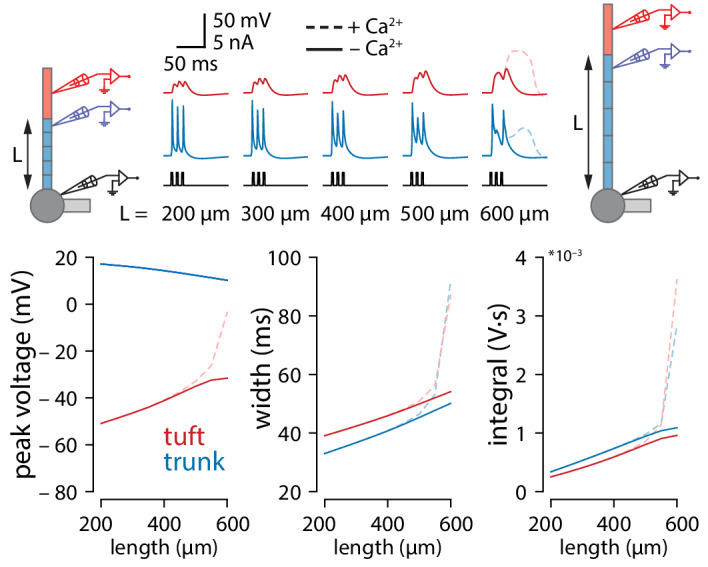
Tuft voltage increases with trunk length independently of conductance gradients.Same experiments as in Figure 3A but with uniform distribution of all active conductances in the apical trunk. Total conductance was maintained for each channel.